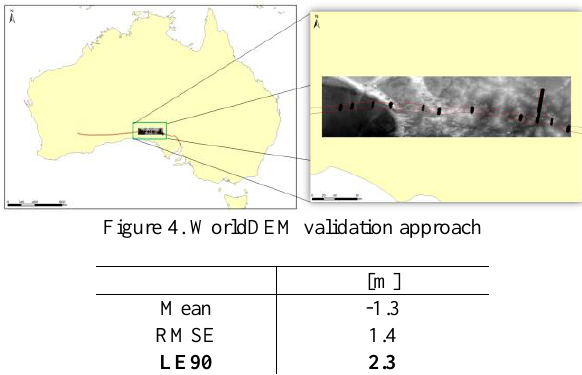
Table 2. ICESat based statistics for the test site in Australia